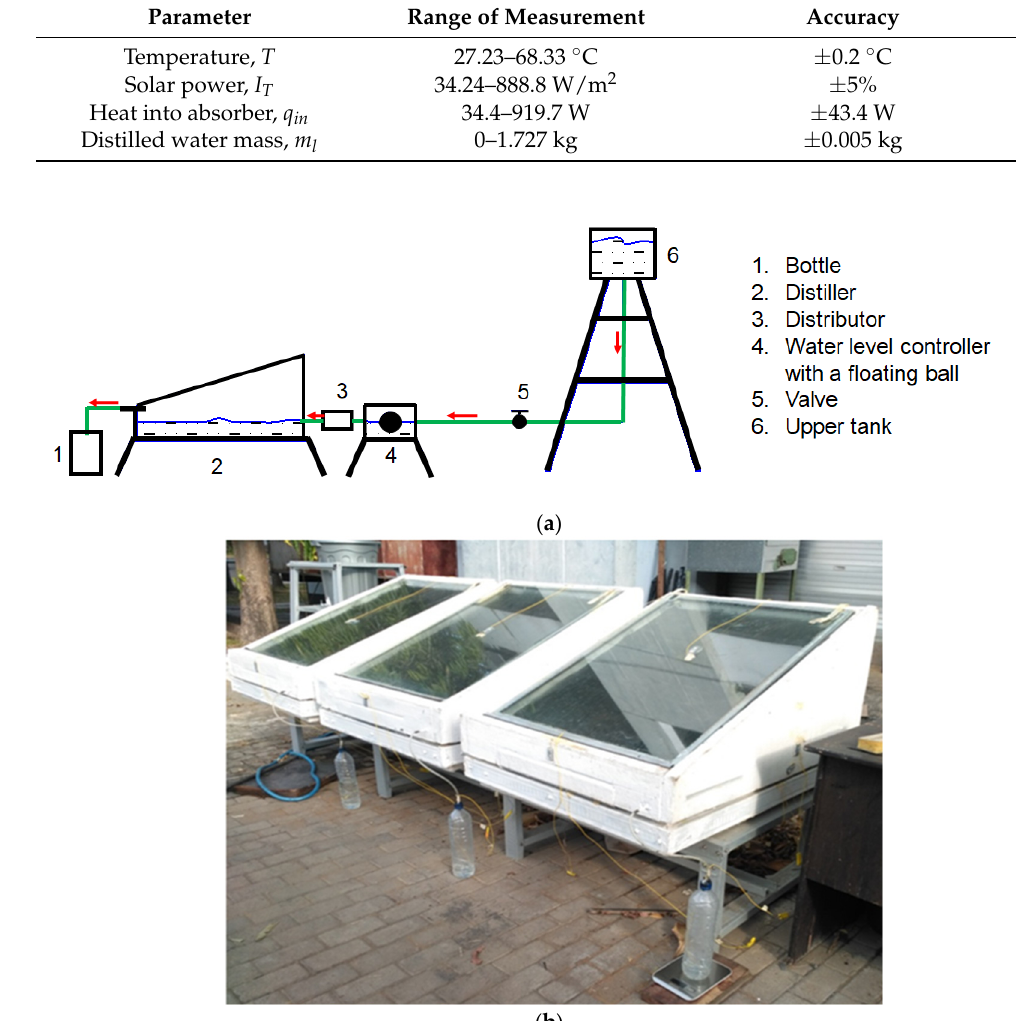
Table 1. Experimental conditions and accuracy.